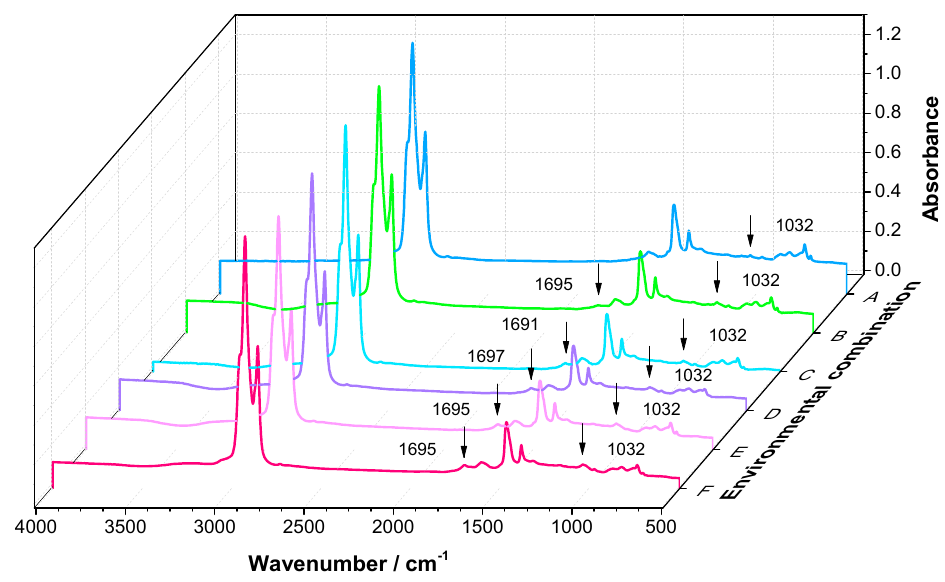
Figure 10. IR spectra of asphalt T under different environmental combinations.